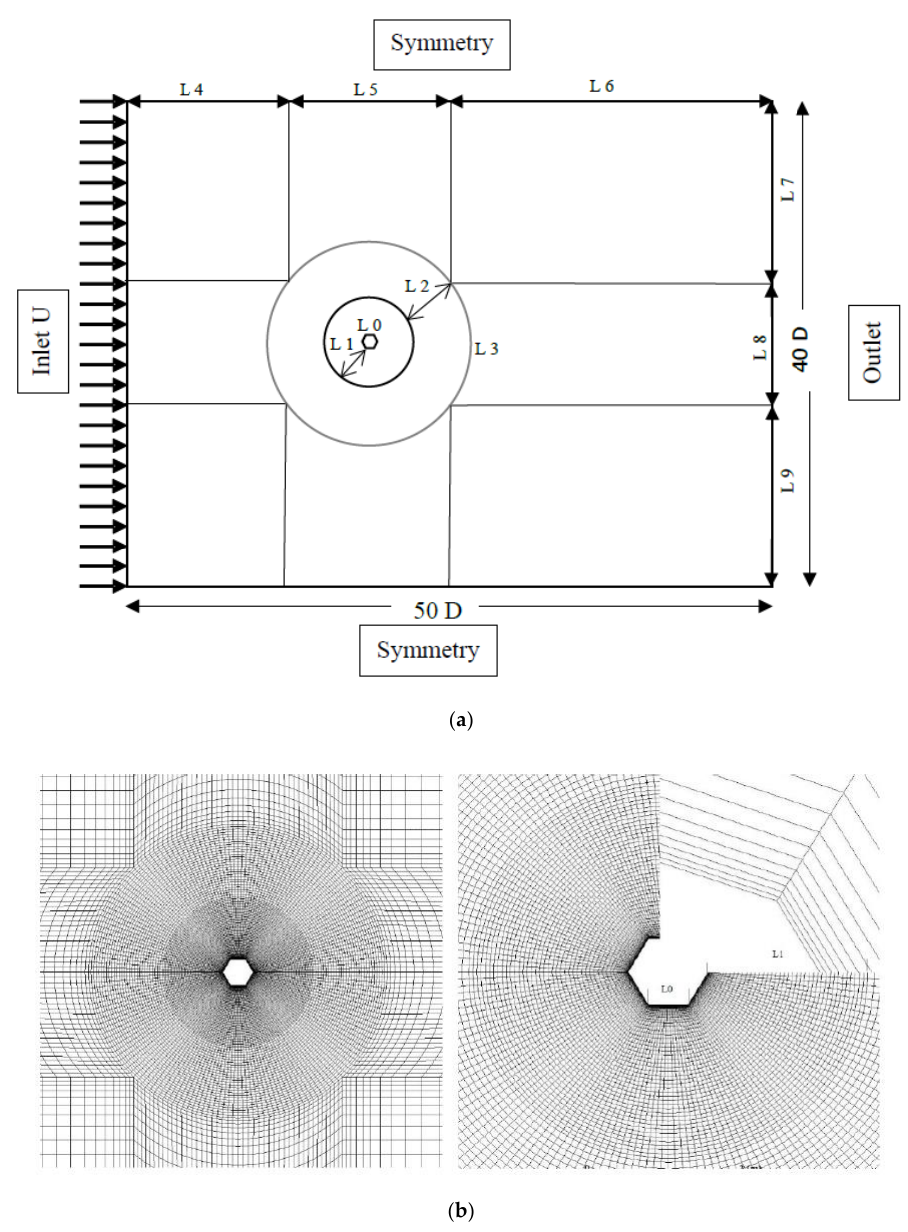
Figure 1. The computational model, showing: ( a ) Parameters used in the mesh convergence study, and ( b ) computational mesh near the corner-oriented hexagonal cylinder.